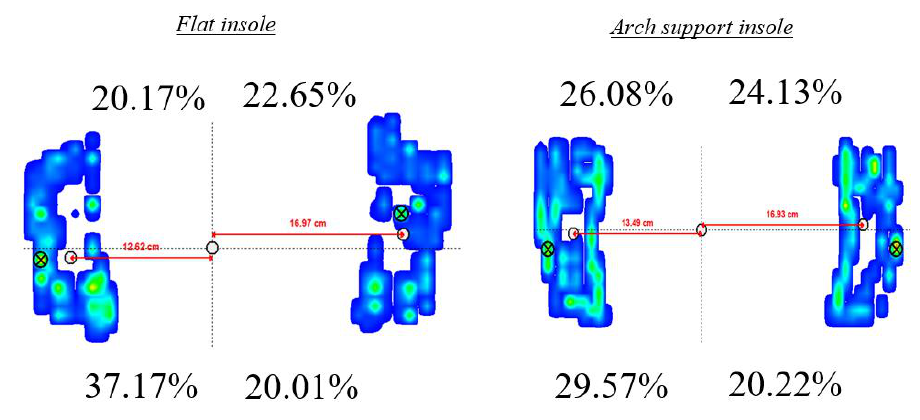
Figure 4. The plantar pressure distribution in the flat insole ( left ) and arch-support insole ( right ). The percentage denotes distribution of plantar pressure across the four zones.